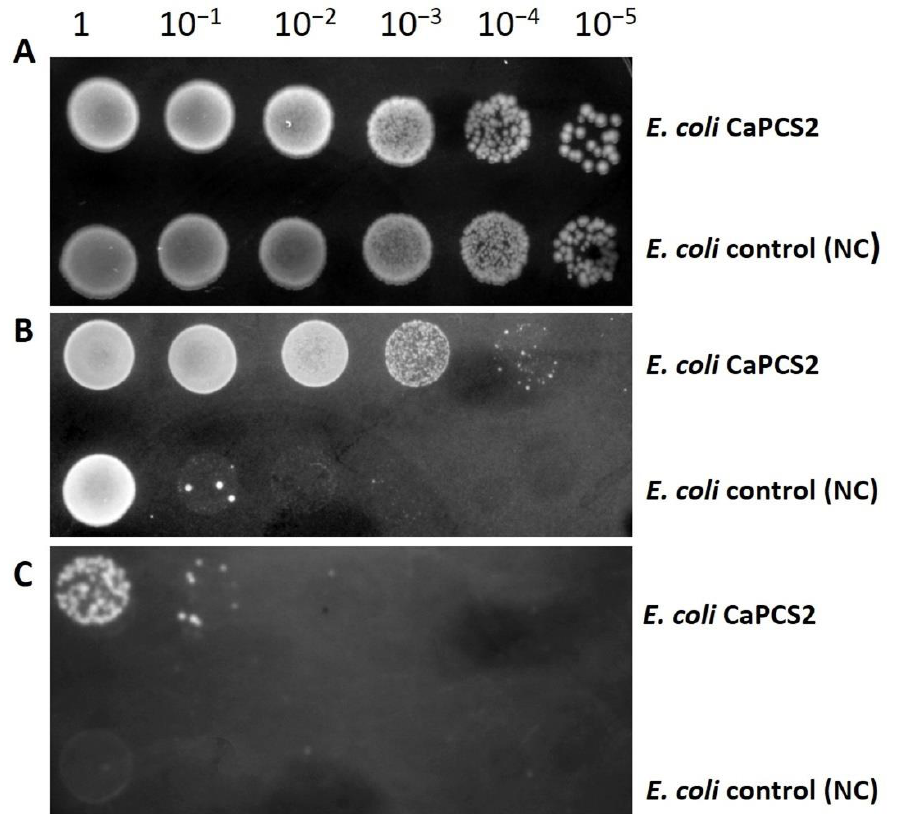
Figure 4. Drop test using serial dilutions of the E. coli negative control (NC) and CaPCS2 strains. ( A ): Control cells not exposed to sodium perchlorate (NaClO 4 ). ( B ): Cells exposed to sodium perchlorate 115 mM. ( C ): Cells exposed to sodium perchlorate 125 mM.